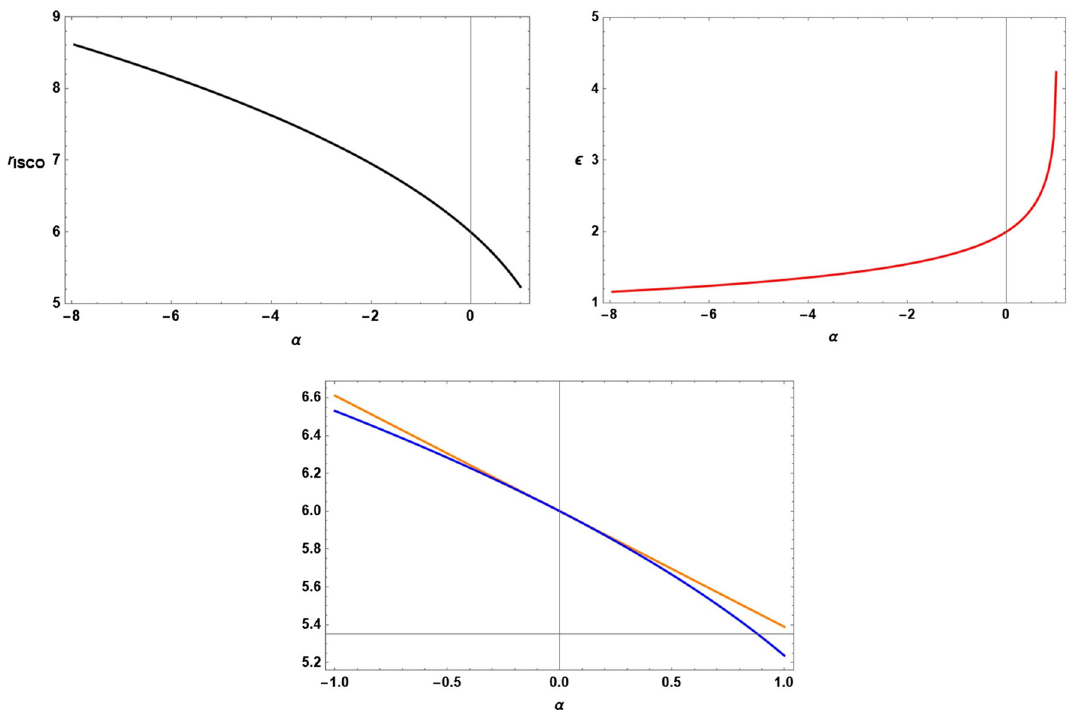
Fig. 2 The upper left panel shows the dependence of the ISCO radius on the GB coupling constant α . The upper right panel shows the devia- tion of ISCO from the event horizon with respect to α . The lower panel